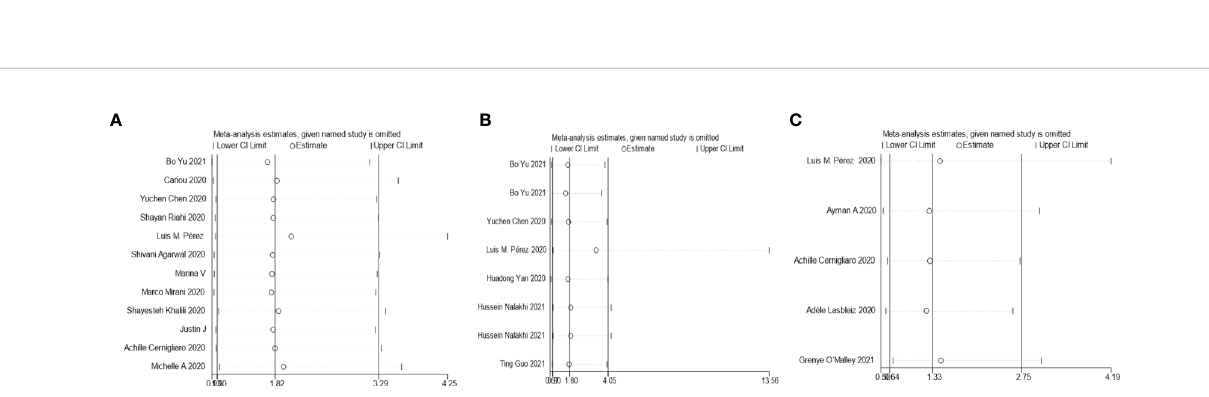
FIGURE 4 | Sensitivity analysis for the effect insulin treatment on the mortality (A) , complications (B) , and the in-hospital admission (C) of COVID-19.